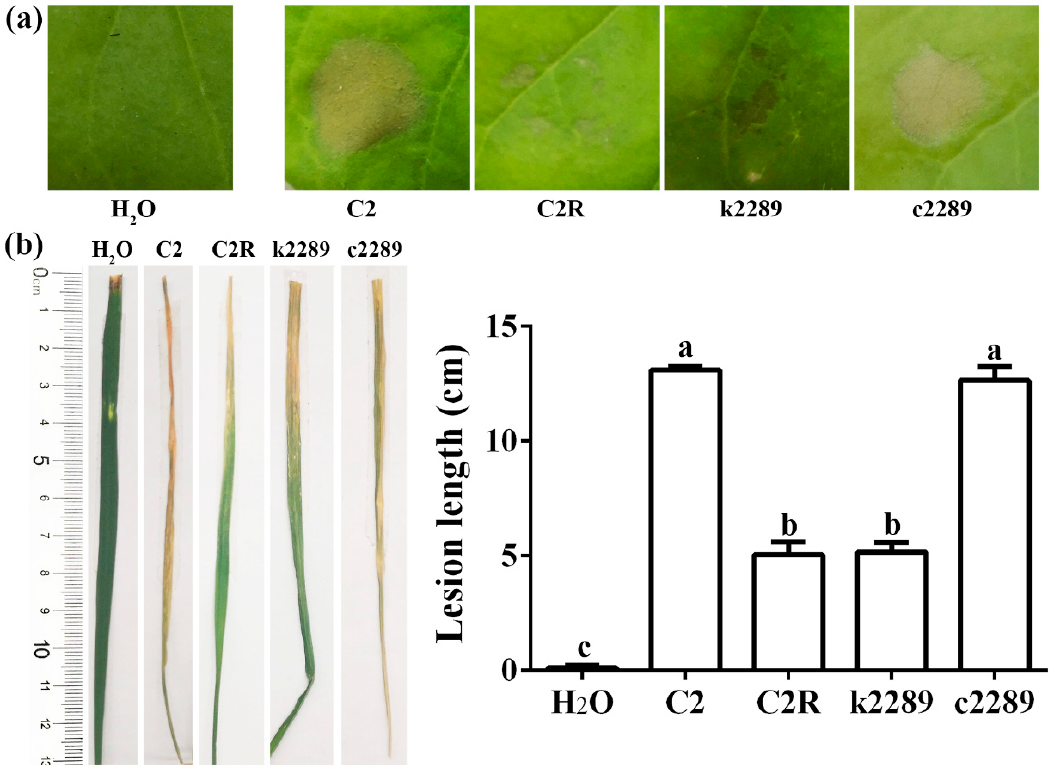
Figure 8. Role of glycosyltransferase gene in Xoo virulence. ( a ) HR lesions in tobacco leaves deter- mined at 24 h after infiltration of Xoo strains. ( b ) Lesions in rice leaves at 14 d after inoculation of Xoo strains. Lesion lengths were presented as means ± standard errors ( n = 3). Columns with different letters are significantly different according to LSD test ( p < 0.05).